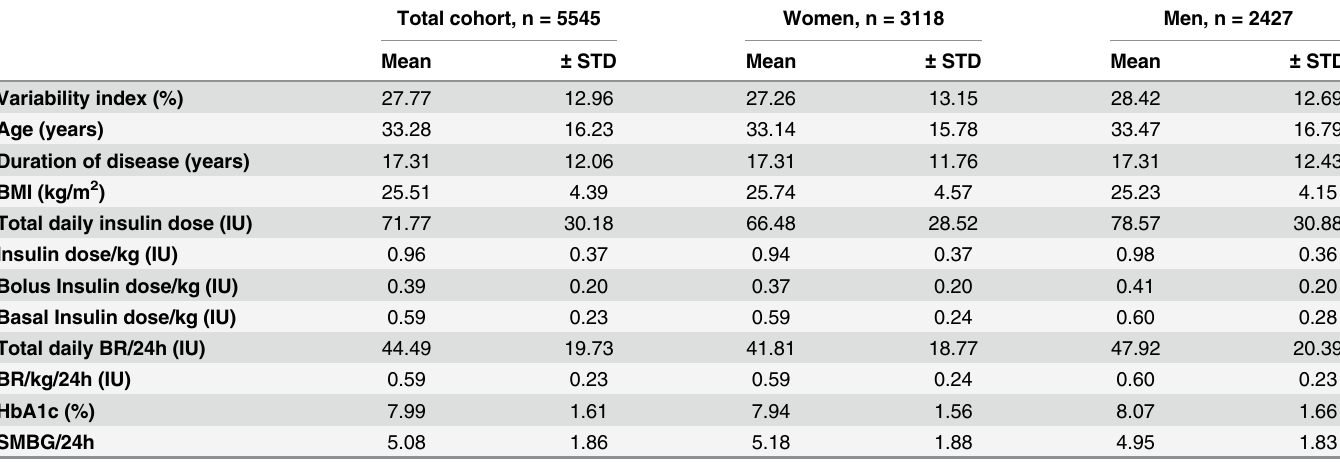
Table 1. Patient characteristics, separated into total cohort, women and men. N =